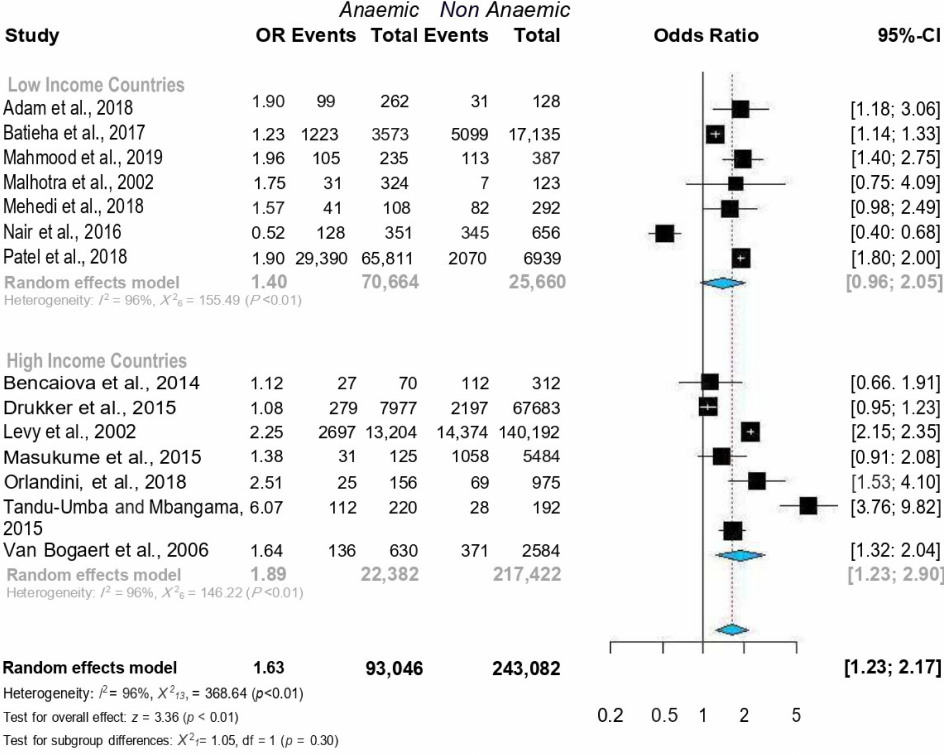
Figure 6. Forest plots of ORs with 95% CIs of the meta-analysis of the anaemia and caesarean delivery subgroup analysis according to World bank classifications. Published data from Adam et al. [27], Batieha et al. [25], Bencaiova et al. [26], Drukker et al. [10], Levy et al. [6], Mahmood et al. [28], Malho- tra et al. [19] Masukume et al. [8] Mehedi et al. [20] Nair et al. [24] Patel et al. [9] Orlandini et al. [21] Tandu-Umba et al. [22] and Van Bogaert et al. [23] were used to calculate the pooled